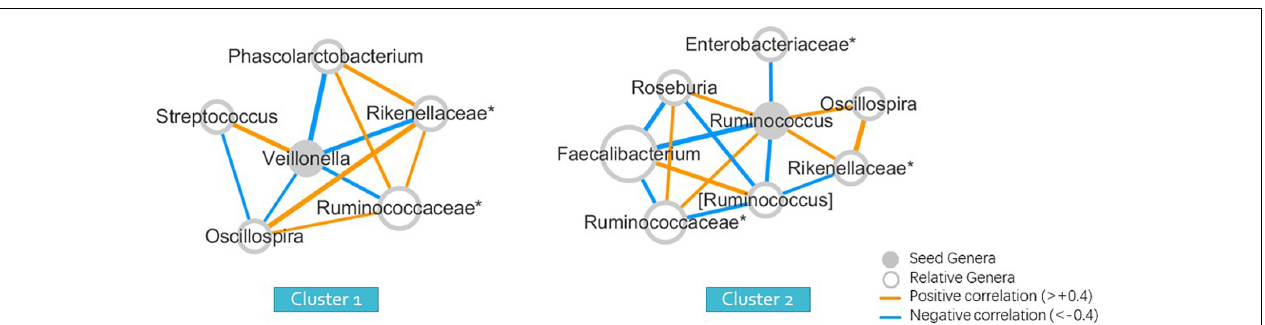
FIGURE 1 | K-means of cluster index.